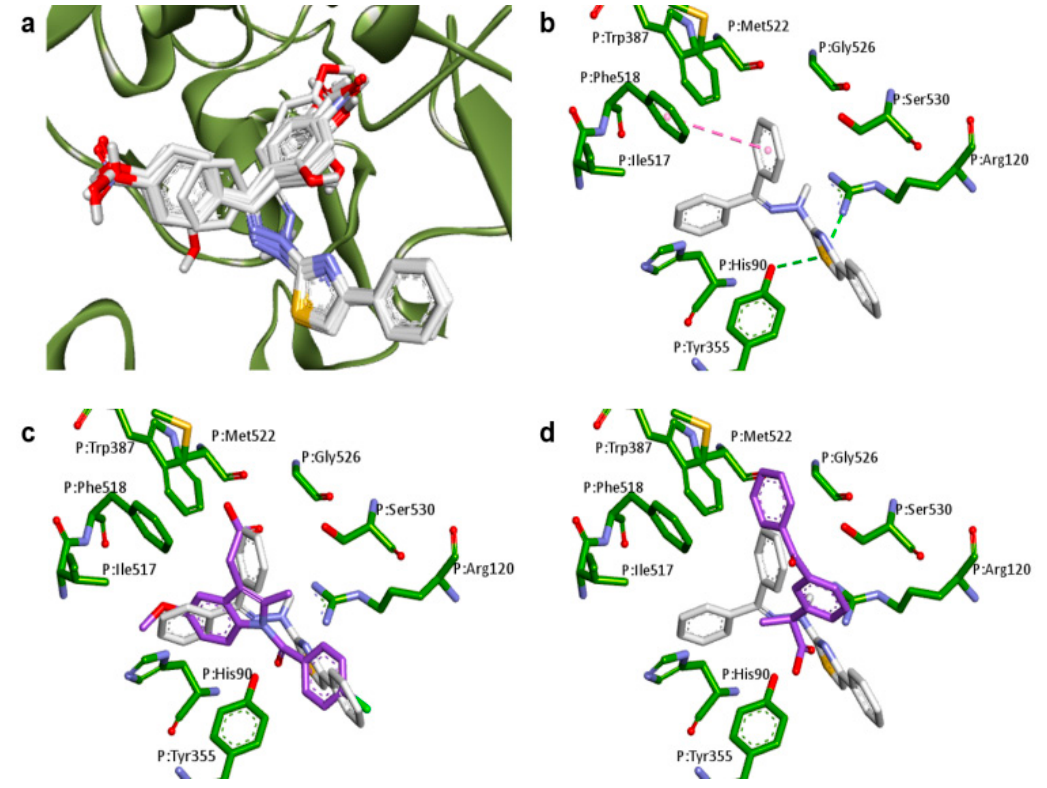
Figure 2. Docking results of planned compounds into COX-1 active site (PDB ID: 2OYU). ( a ) Conformation of planned compounds found in their most stable complex with COX-1; ( b ) Interaction of 3a (white carbons, yellow sulfurs, blue nitrogens and red oxygens) and COX-1 active site (green carbons). Hydrogen bonds (dotted green line) and pi-pi stacking interactions (dotted pink line) are indicated; ( c ) Conformation comparison between 3a (white carbons) and indomethacin (purple carbons) interacting with COX-1 (green carbons); ( d ) Conformation comparison between 3a (white carbons) and ketoprofen (purple carbons) interacting with COX-1 (green carbons).